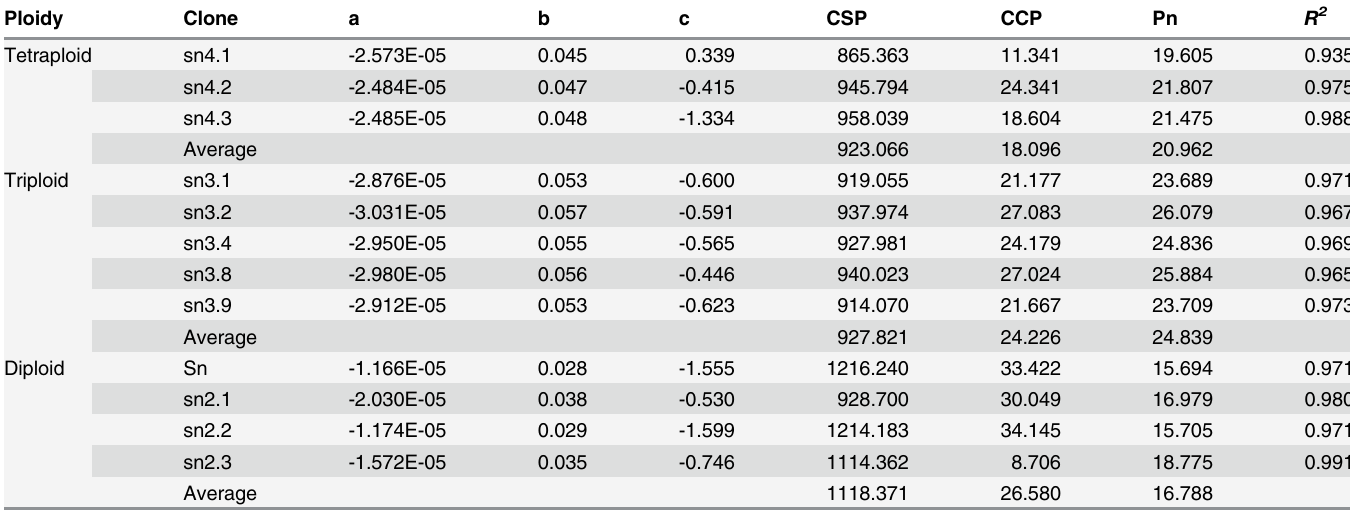
Table 4. Coefficients and variation parameters for each Pn-Ca simulated curve.